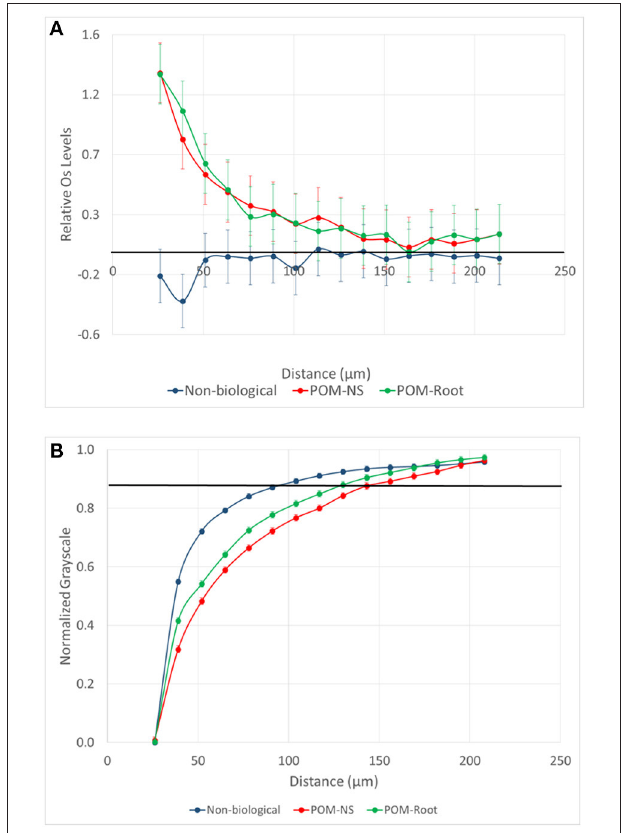
FIGURE 6 | (A) Mean difference from the background level for Os stained samples as a function of distance from pores of biological origin with plant roots (POM-Root) and with non-root derived POM (POM-NS) and from non-biological pores ( n = 6). The samples are from the biologically based system. Positive values indicate increased presence of Os labeled SOM, while negative values indicate a decrease in Os labeled SOM. (B) Normalized grayscale values for all three studied pore types from all three management practices. Dots are averages and the standard errors are equal to the size of the dots at each distance. The solid black lines represent the background Os labeled level (on A ) and the background grayscale value (on B ).